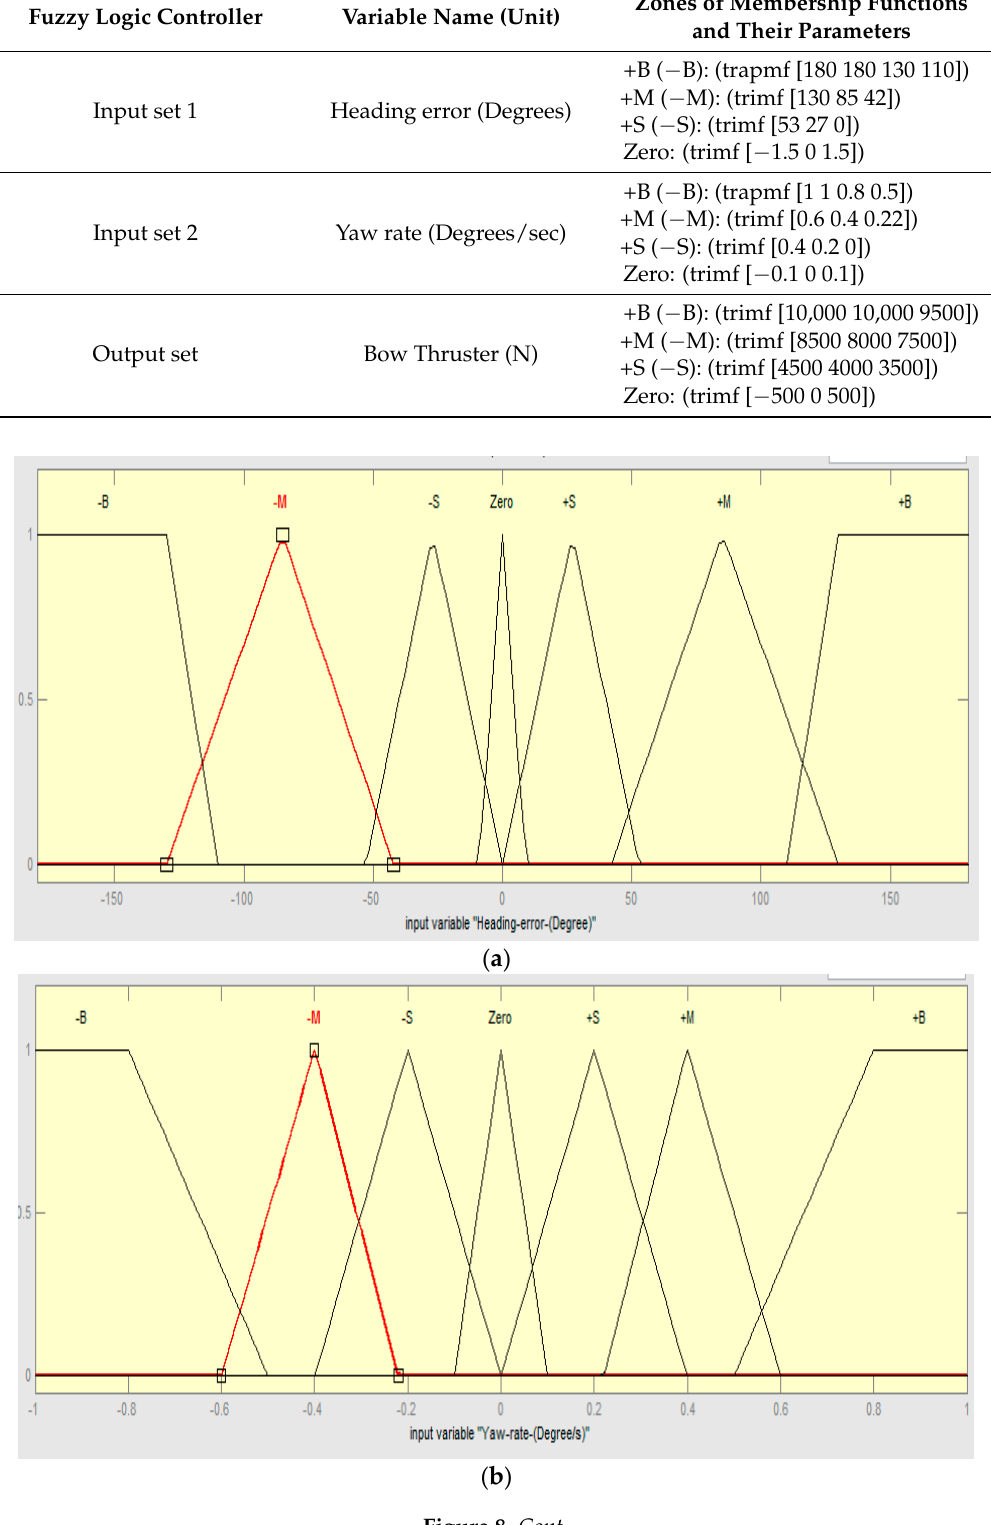
Table 4. The parameters of heading controller.